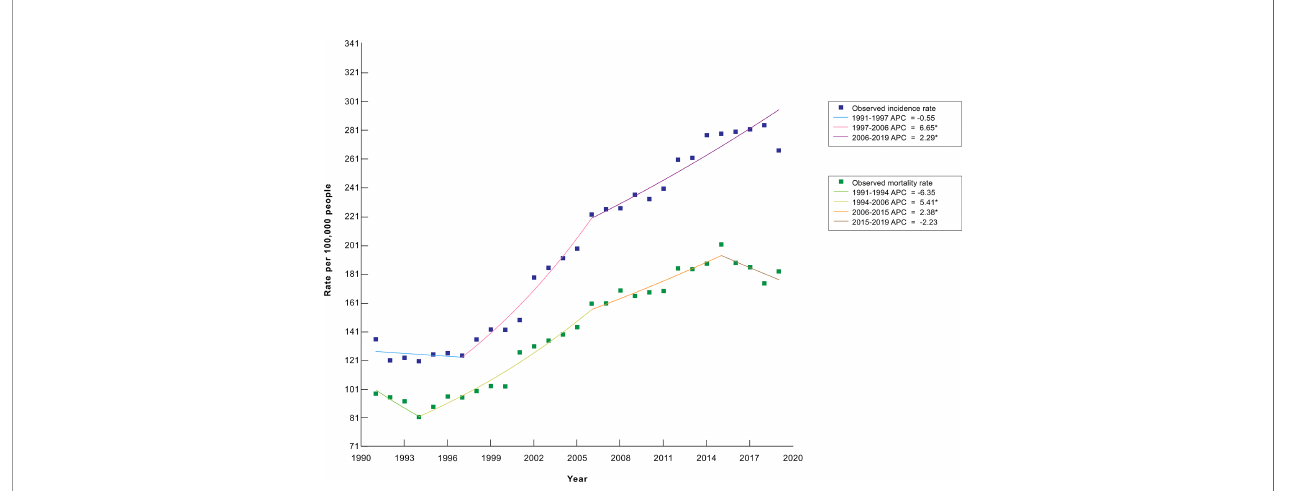
FIGURE 2 | Trends in the crude cancer incidence rate and the crude cancer mortality rate from 1991 to 2019 in Armenia, per 100,000 people a . a Data are adapted from the Statistical Yearbook of Armenia: Health and Healthcare 2020 (3) and the Statistical Yearbook of Armenia 1993-1994, 1995-1996, 2001, 2004, and 2009 (23 – 27). *Indicates that the Annual Percent Change (APC) is signi fi cantly different from zero at the alpha = 0.05